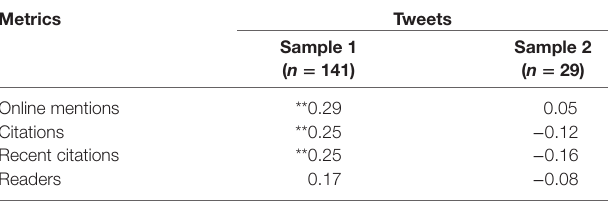
TaBle 7 | Correlation between author-level metrics and number of Tweets.